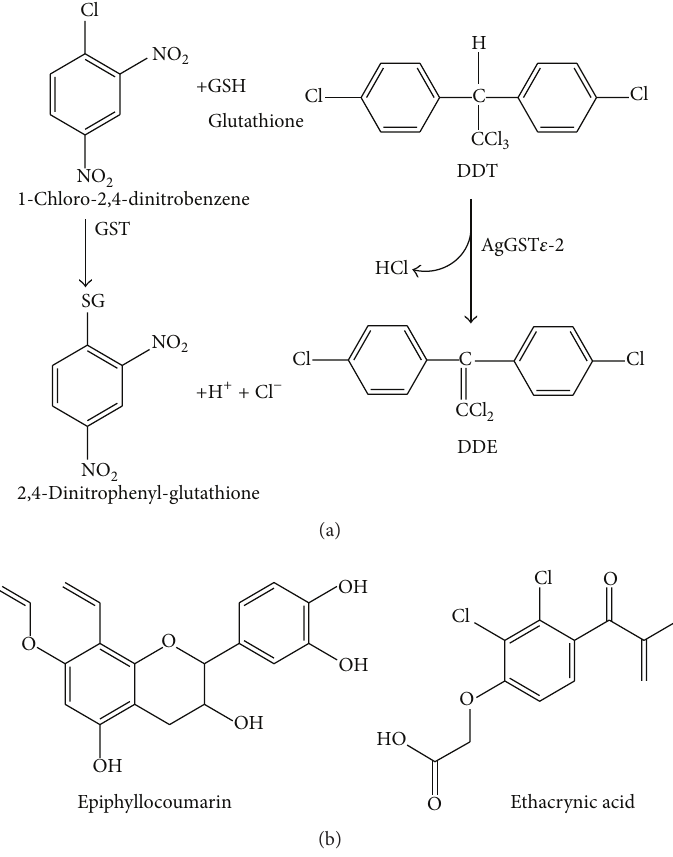
Figure 1: The conjugation reaction of 1-chloro-2,4-dinitrobenzene and DDT (a) as catalyzed by GSTs and (b) the compounds used in this study for the determination of inactivation properties of AgGST 𝜀